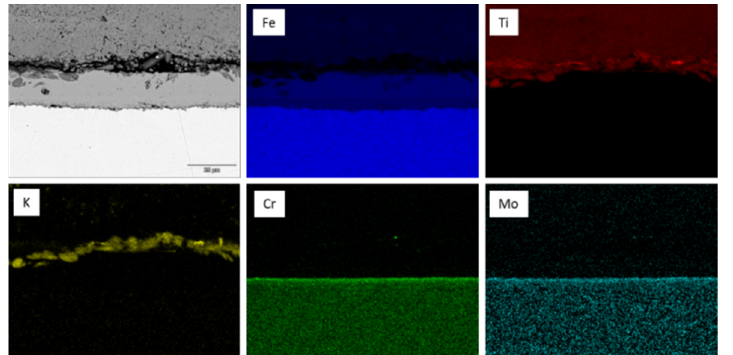
Figure 9. Back-scattered SEM image and elemental maps of 10CrMo9-10 covered with K-Ilmenite red after exposure at 550°C in CO 2 /H 2 O during 168 h showing K (yellow), Fe (blue), Ti (red), Cr (green), and Mo